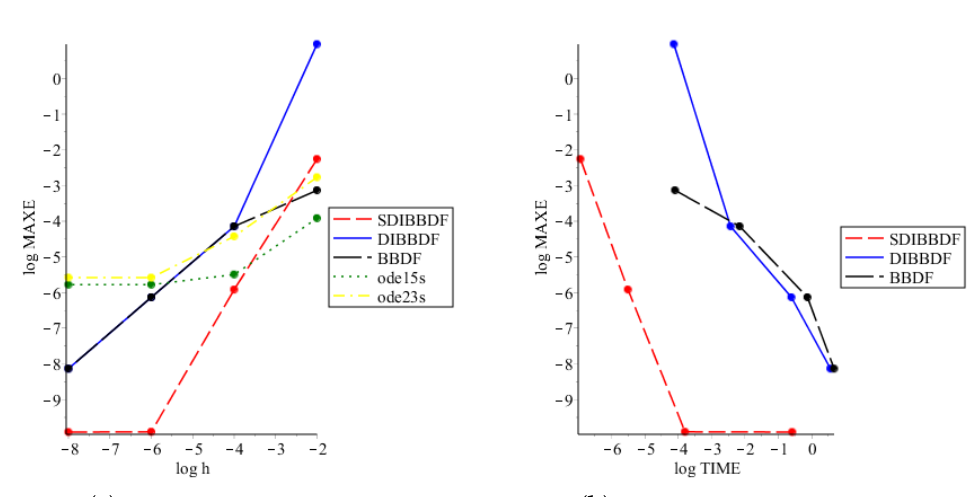
Figure 6. Efficiency curves for test problem